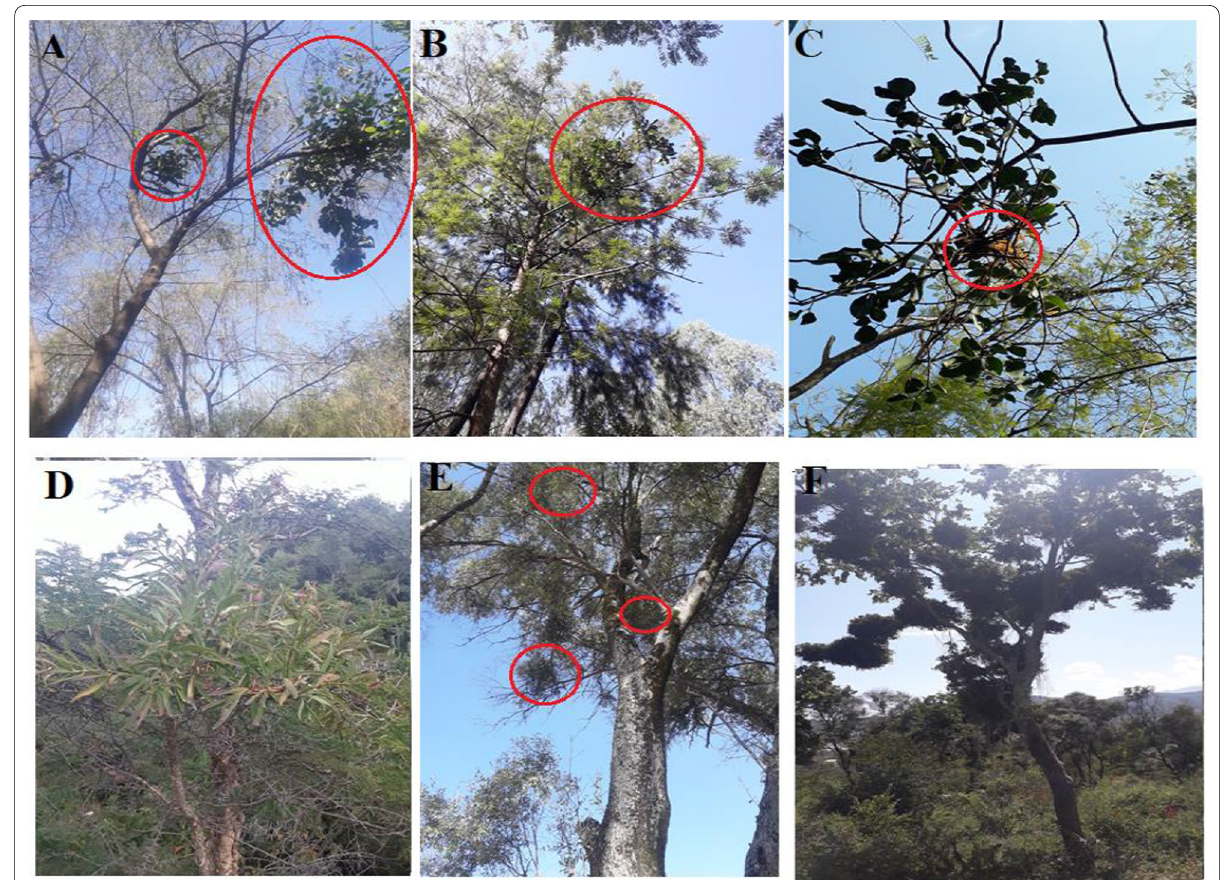
Fig. 1 The potential host adaptive ranges and specificity of mistletoes. Erianthemum dregei (hairy mistletoe) infecting A Sesbania sesban and B Grevillea robusta ; Tapinanthus globiferus subsp. apodanthus parasitizing C Jacaranda mimosifolia ; Amyema pendula infecting D Acacia abyssinica ; and Viscum album growing on E Olea europaea subspec. cuspidata and F Cordia myxa (Photo by Meseret Muche